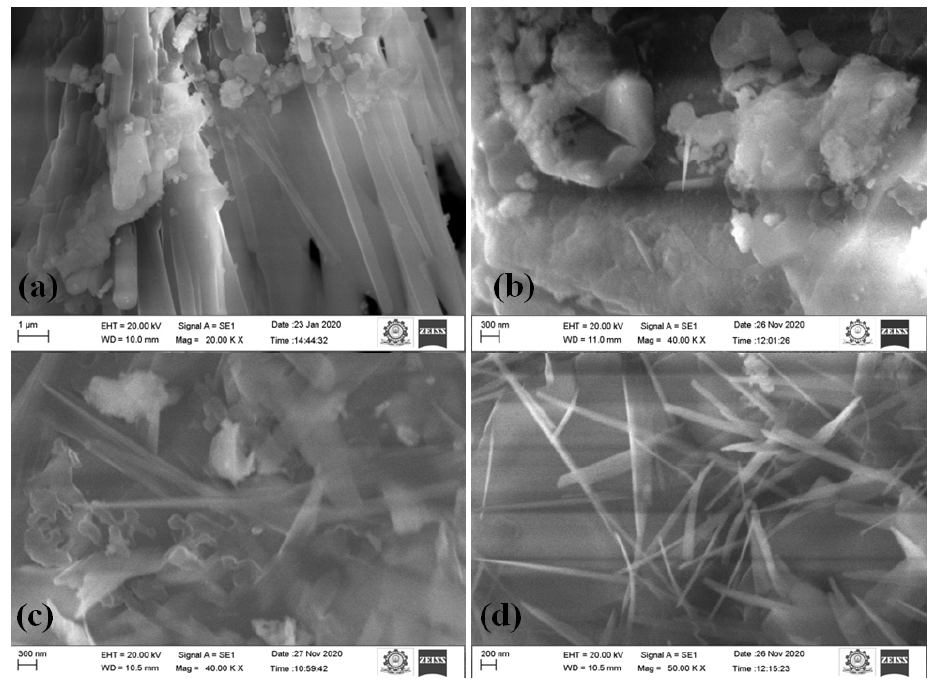
Fig. 2. SEM images of (a) pure (b) Cu-1 (c) Cu-2 (d)